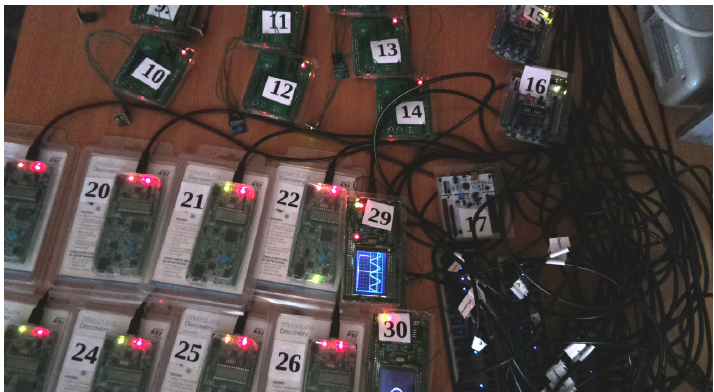
Figure 8. View from Raspi Cam connected to Eridanus